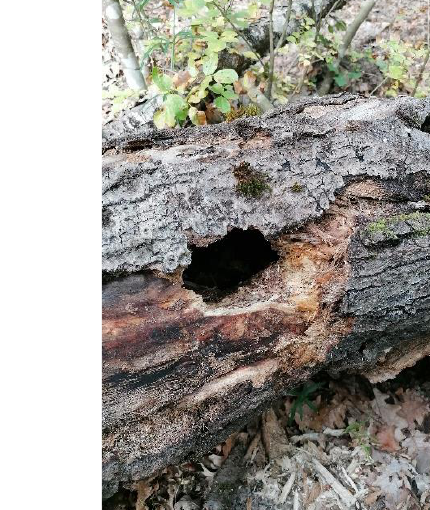
Figure 1. Deadwood: standing and lying trunks, fallen branches, and coarse wood debris.